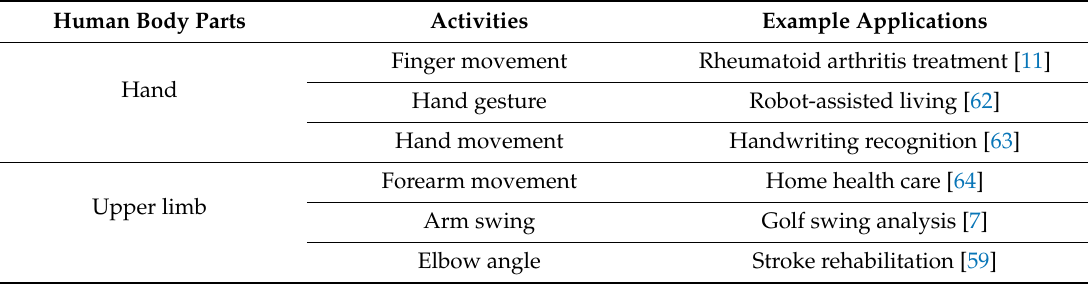
Table 1. Identifiable human activities and example